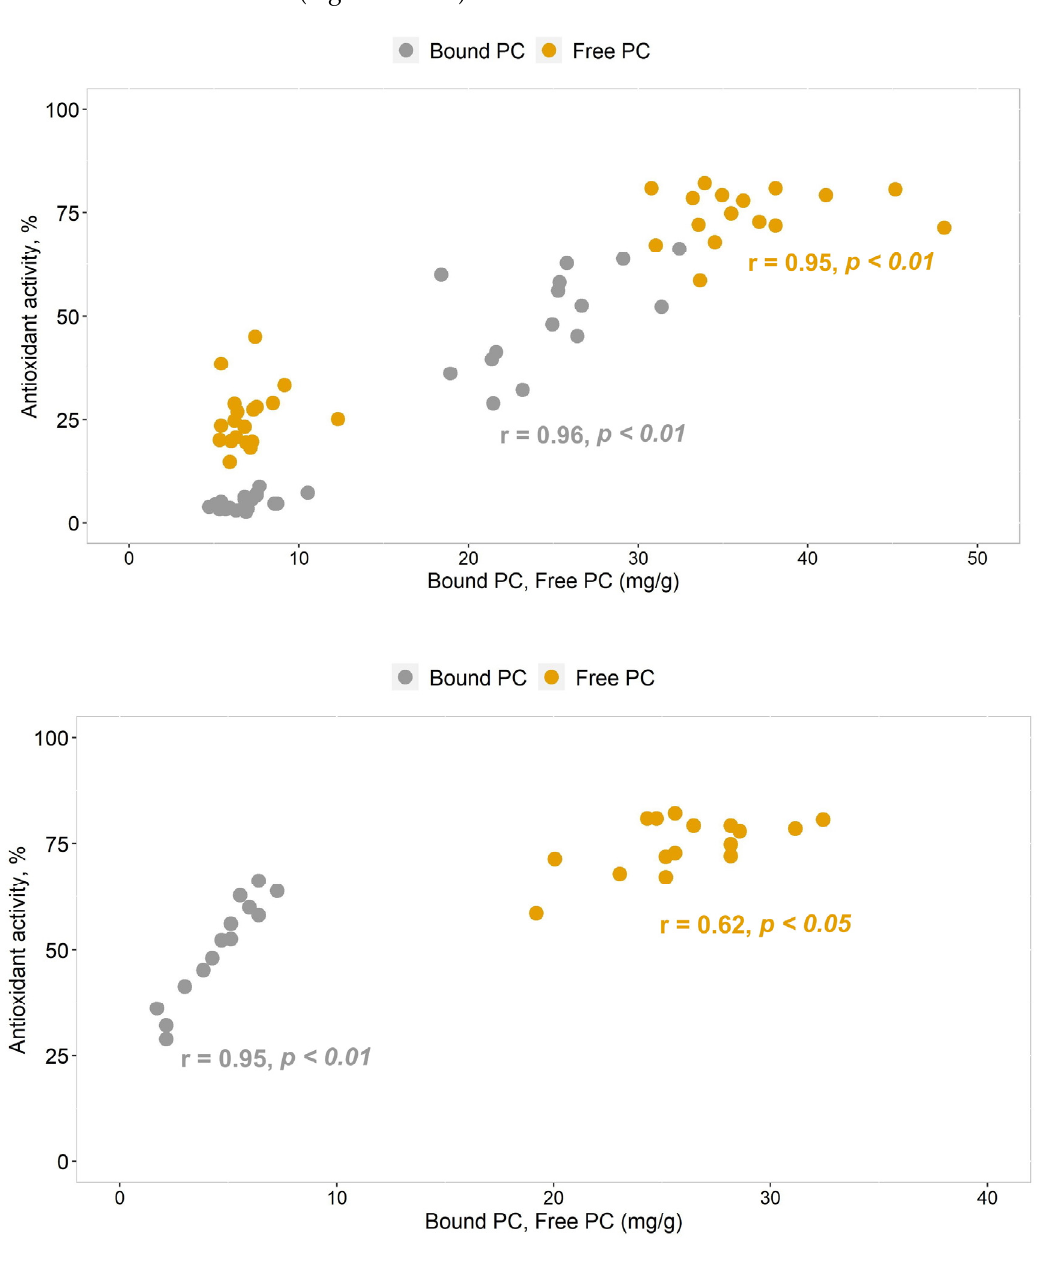
Figure 3. Correlations of total phenolic compounds (upper graph) and total flavonoids (bottom graph) content and antioxidant activity (according to DPPH•) in Betula free PC and bound PC ex-